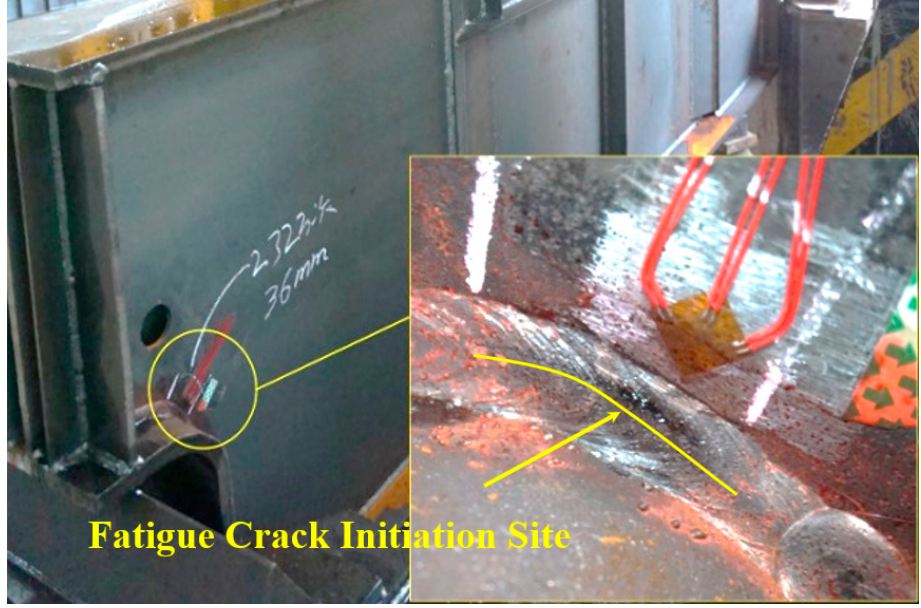
Figure 8. Cracks originated at the weld root and penetrated through the weld.